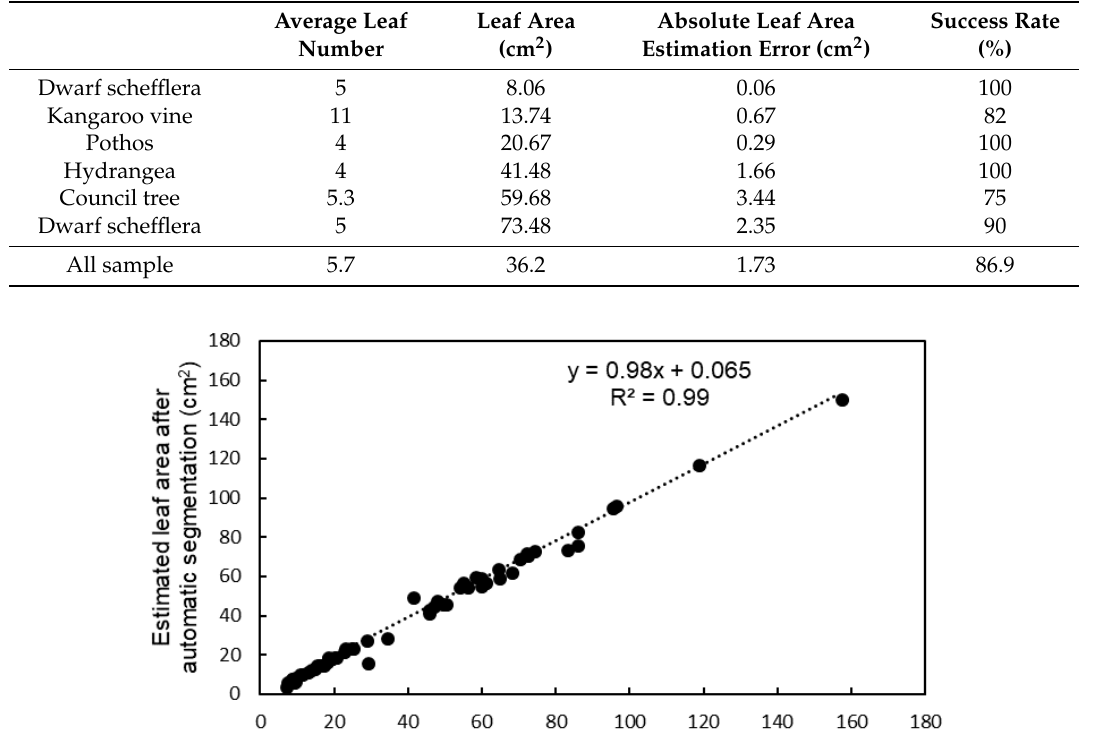
Figure 3. Segmentation results of plants: plants in image ( a ) (Council tree) and ( b ) (Kangaroo vine) have 8 and 11 leaves, respectively; images ( a , b ) represent 3D point-cloud images of the target plants; images ( c , d ) show the results of segmentation of images ( a , b ), respectively. Table 1. Accuracy of leaves are estimations and leaf segmentation of each plant; success rate represents the percentage of leaves correctly segmented with more than 90% leaf area estimation accuracy.